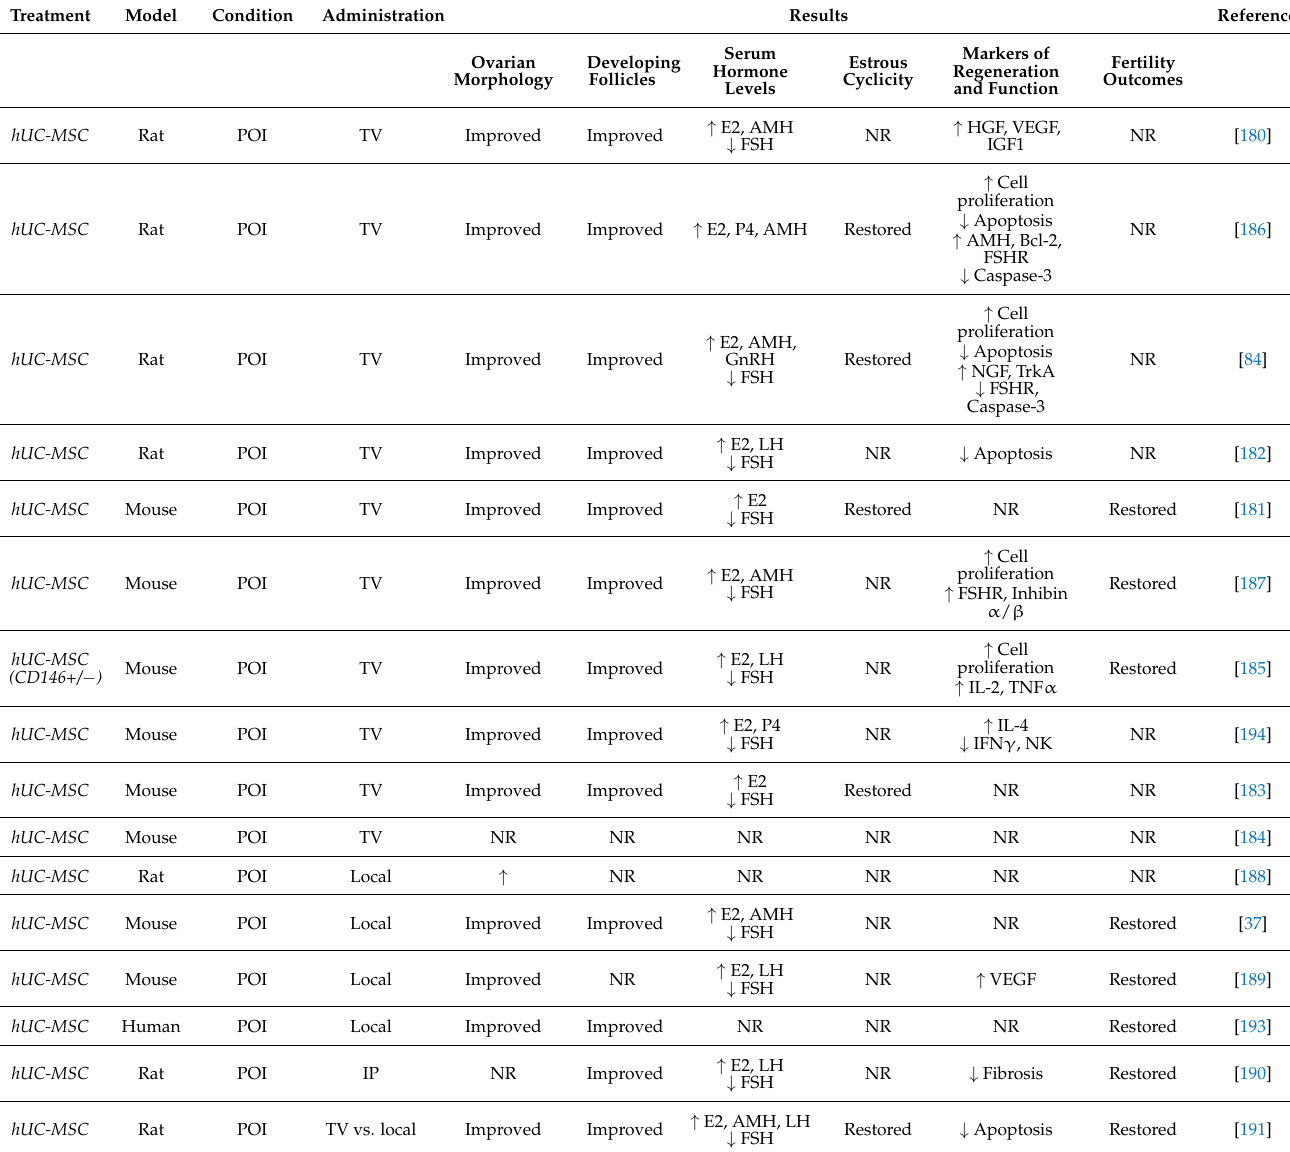
Table 2. Outcomes of studies applying hUC-MSCs or their derivatives (with or without bioengineered scaffolds) to treat ovarian